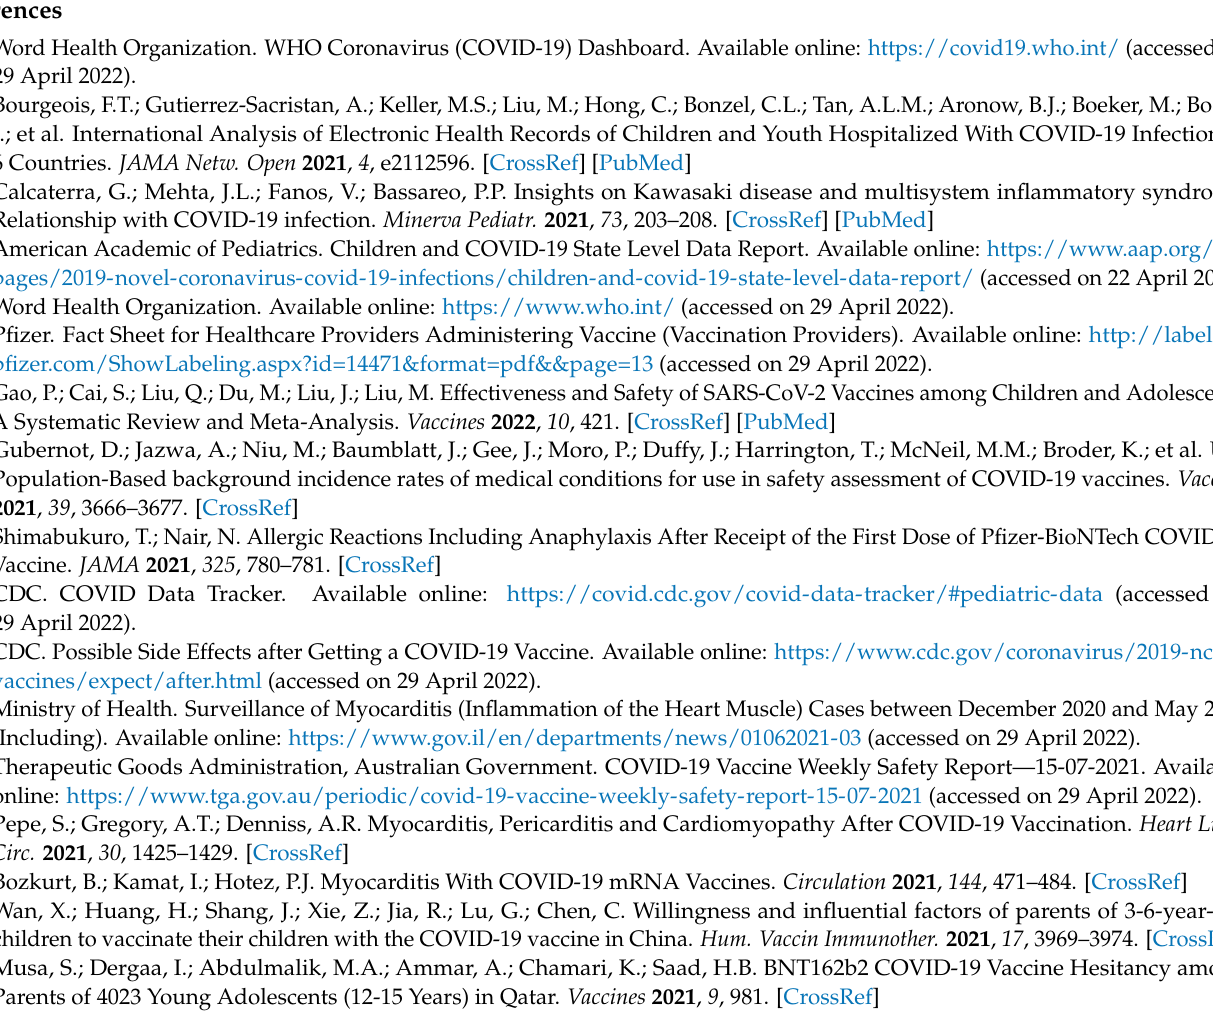
Figure S2: Incidence of myocarditis or pericarditis after the first dose of a vaccine, Figure S3: Incidence of myocarditis or pericarditis after the second dose of a vaccine, Figure S4: Incidence risk relative to the second and first doses, Figure S5: Male and female relative risk incidence of myocarditis or